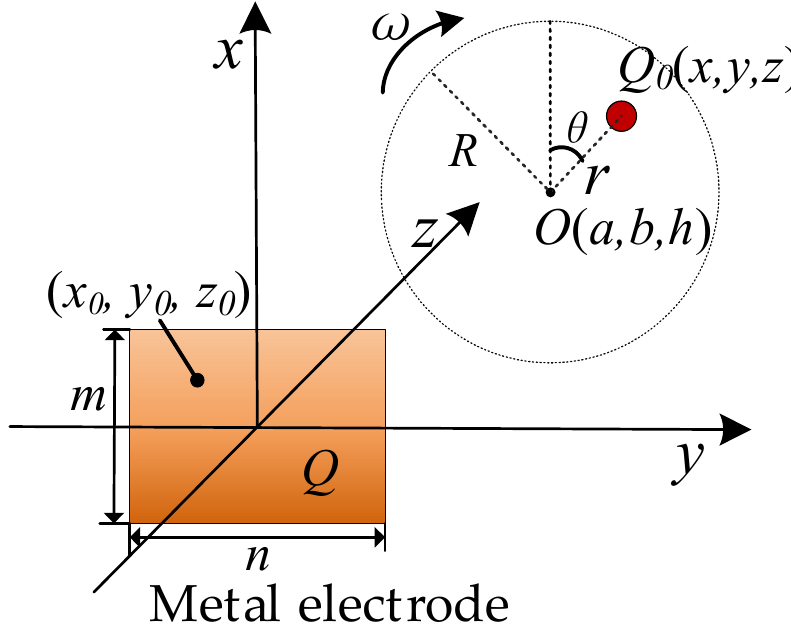
Figure 1. The principle of measuring rotor rotation based on charge induction.